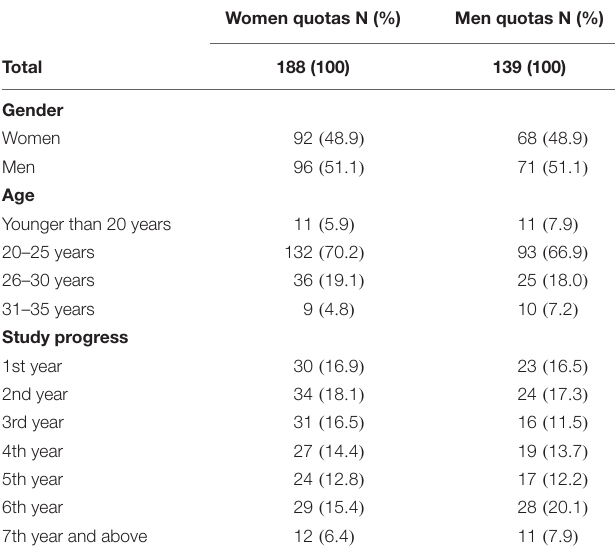
TABLE 1 | Participants’ sociodemographic characteristics by stimulus (women vs. men